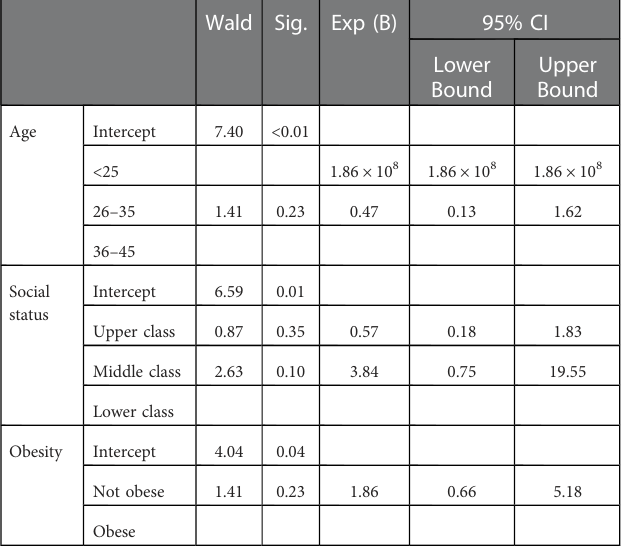
TABLE 5 Multinomial regression analysis in fl uence of factors on RPL according to ASRM/ESHRE (2 RPL) and wHO/RCOG ( ≥ 3 RPL)